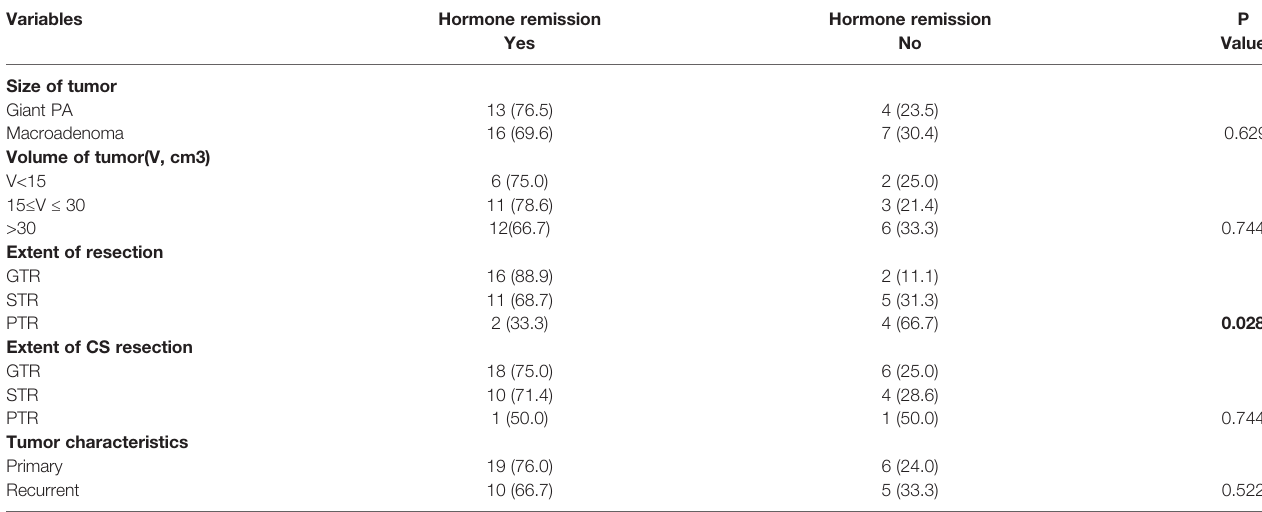
TABLE 6 | Endocrine outcomes correlated with multiple potential variables.